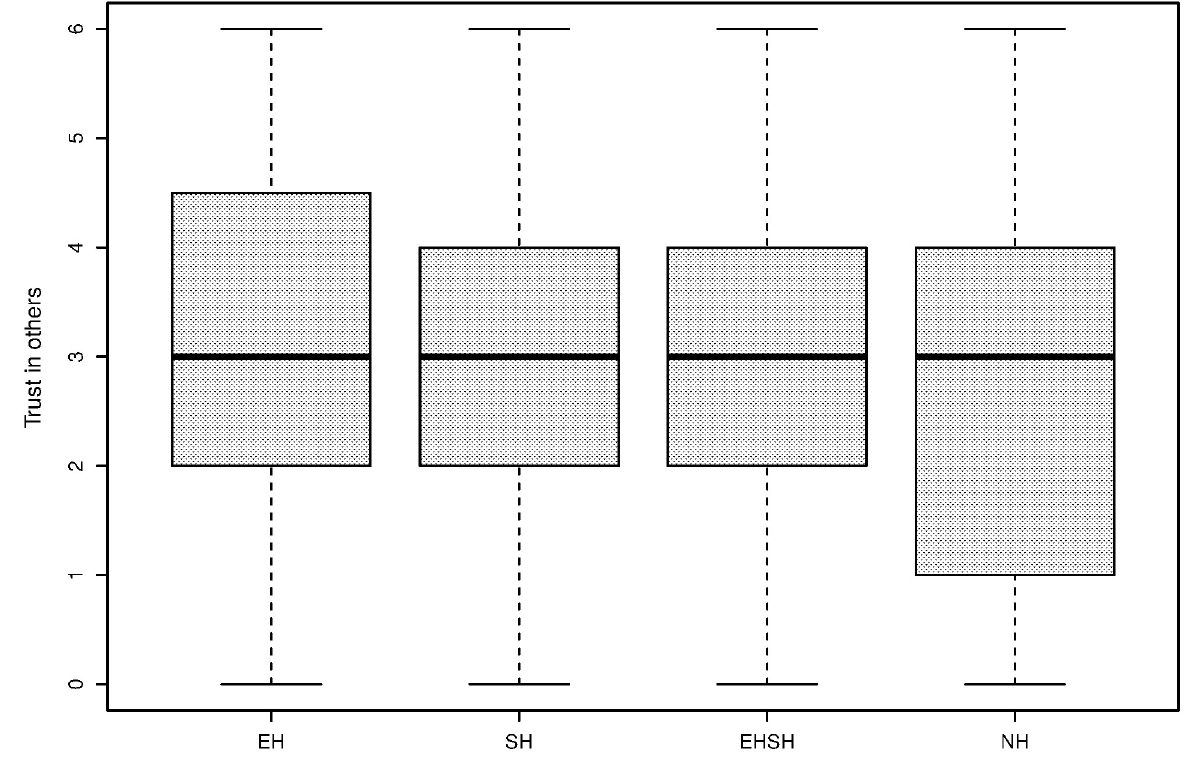
Fig 10. Trust in other players by